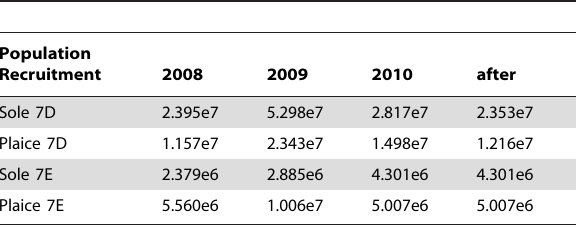
Table 1. Recruitment (in number) values used for the first three simulated years and